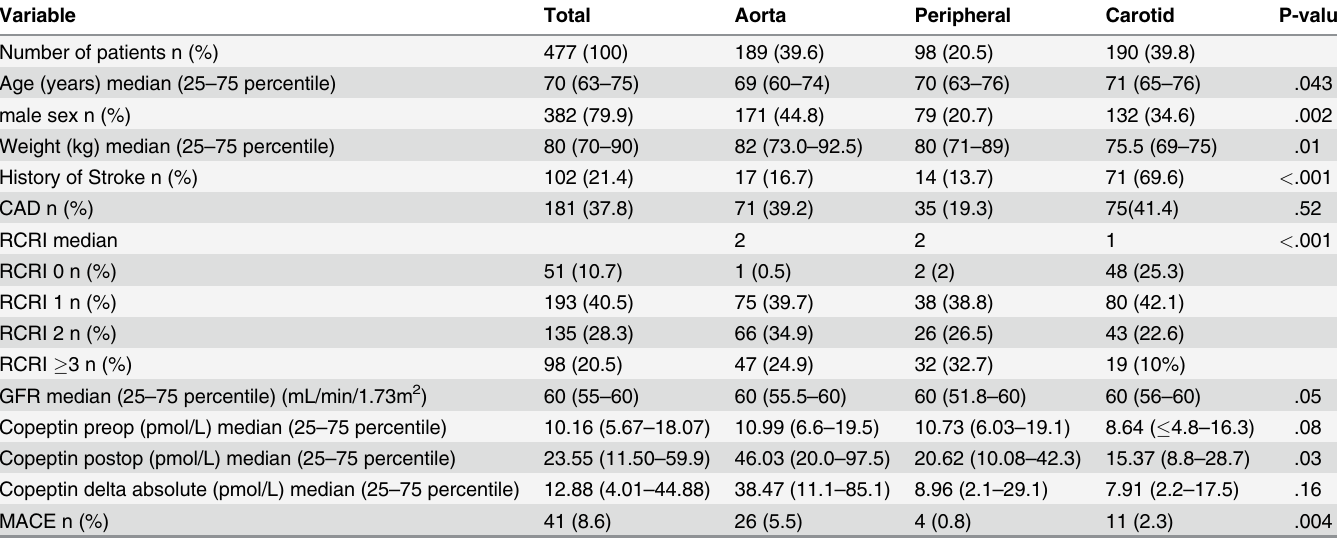
Table 1. Demographical data of study population subdivided into surgical